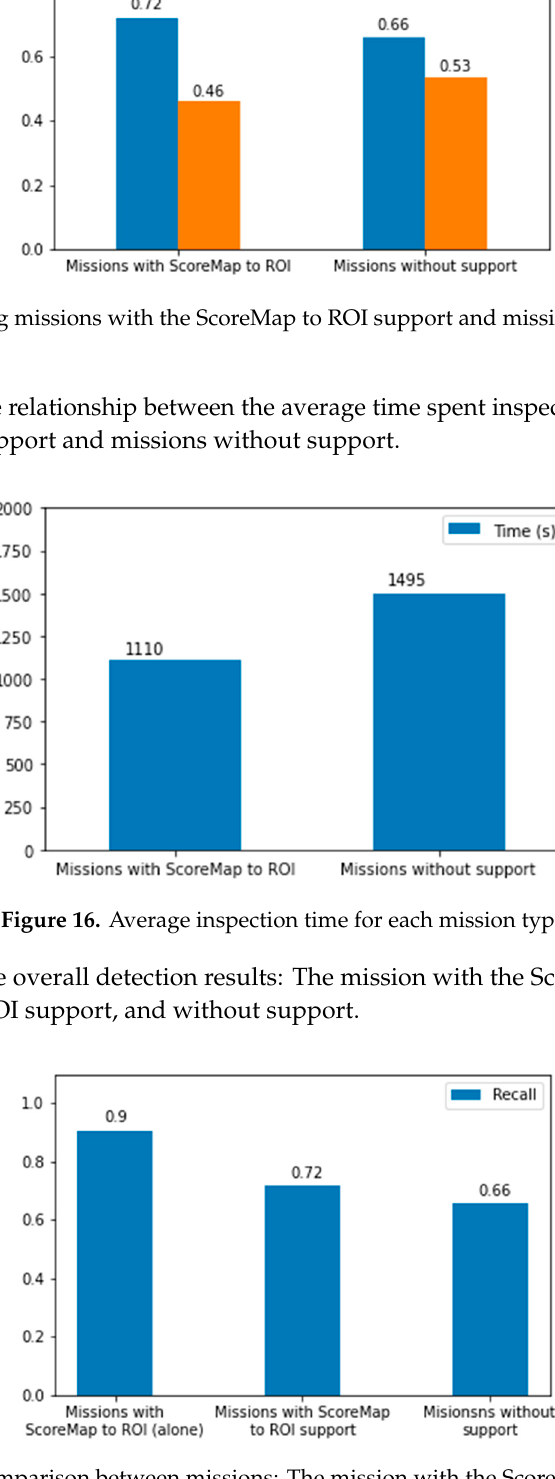
Figure 14. The results of participants in missions without support.